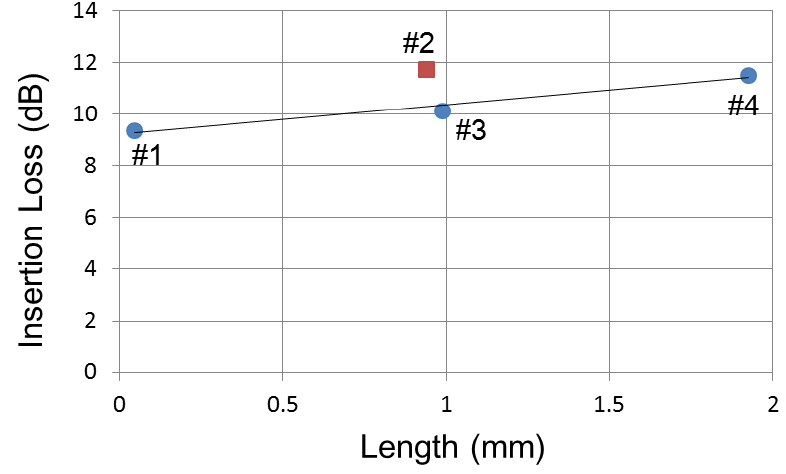
Figure 6. Length dependence of the insertion loss of an MMI waveguide with fins.